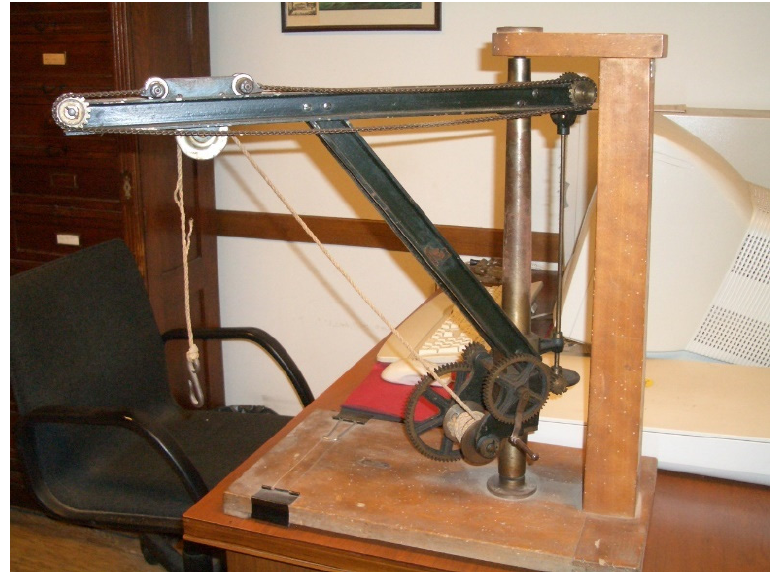
Figure 11. An example of an industrial-like crane model stored as in Figure 9.